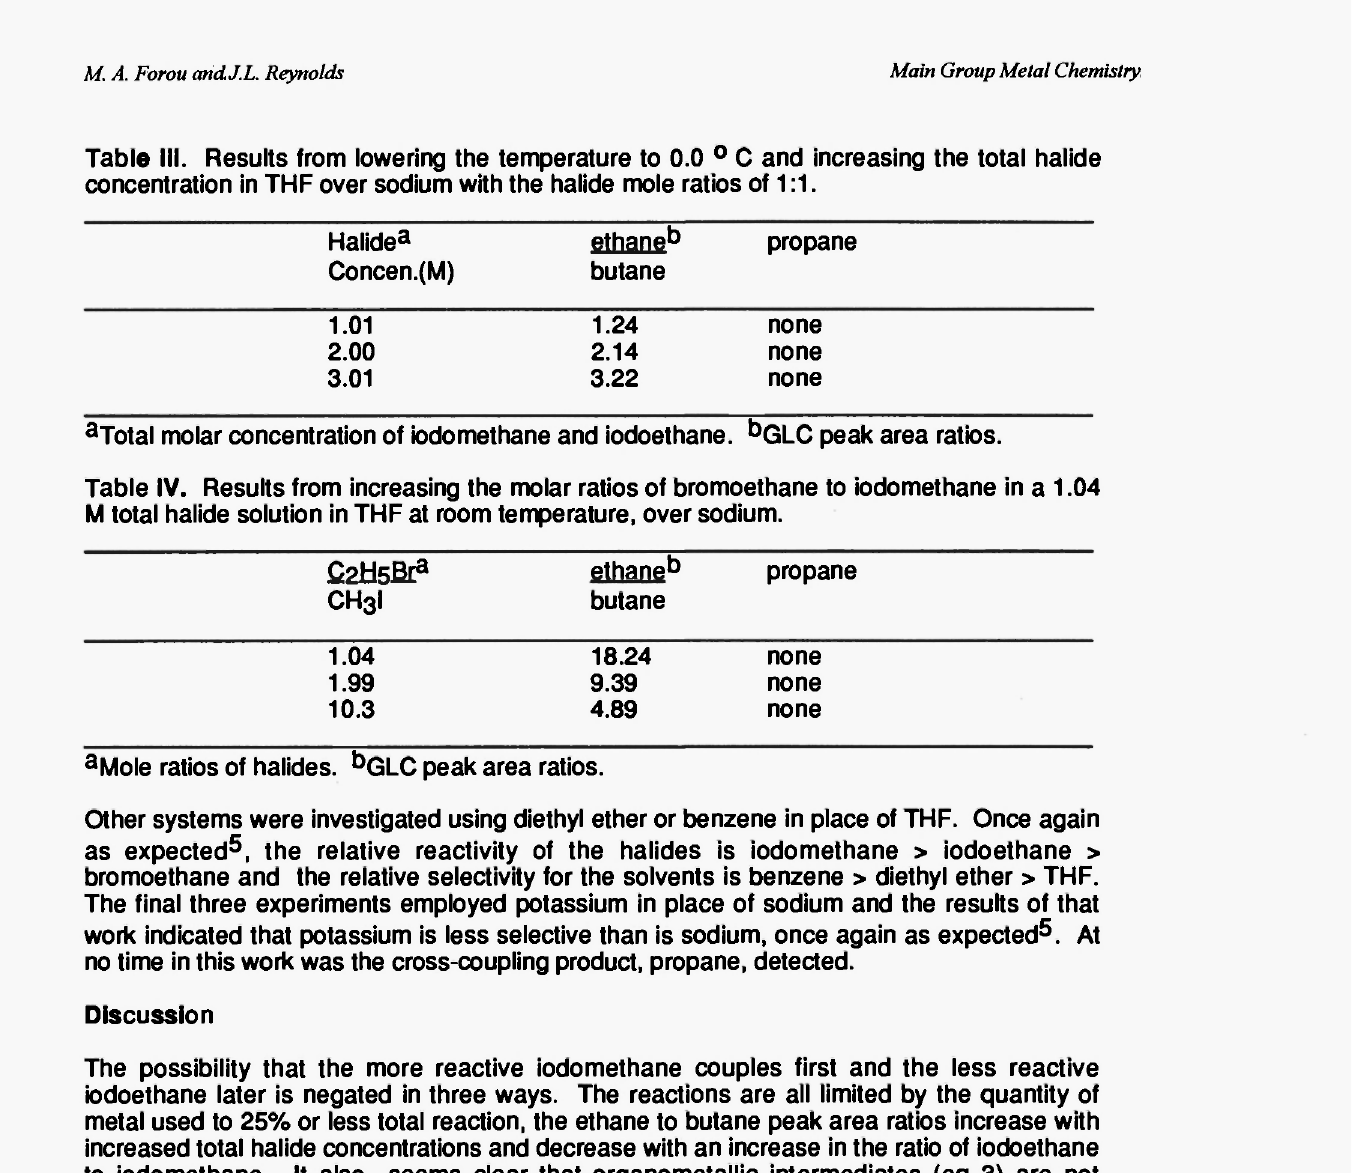
Table III. Results from lowering the temperature to 0.0 0 C and increasing the total halide concentration in THF over sodium with the halide mole ratios of 1:1.